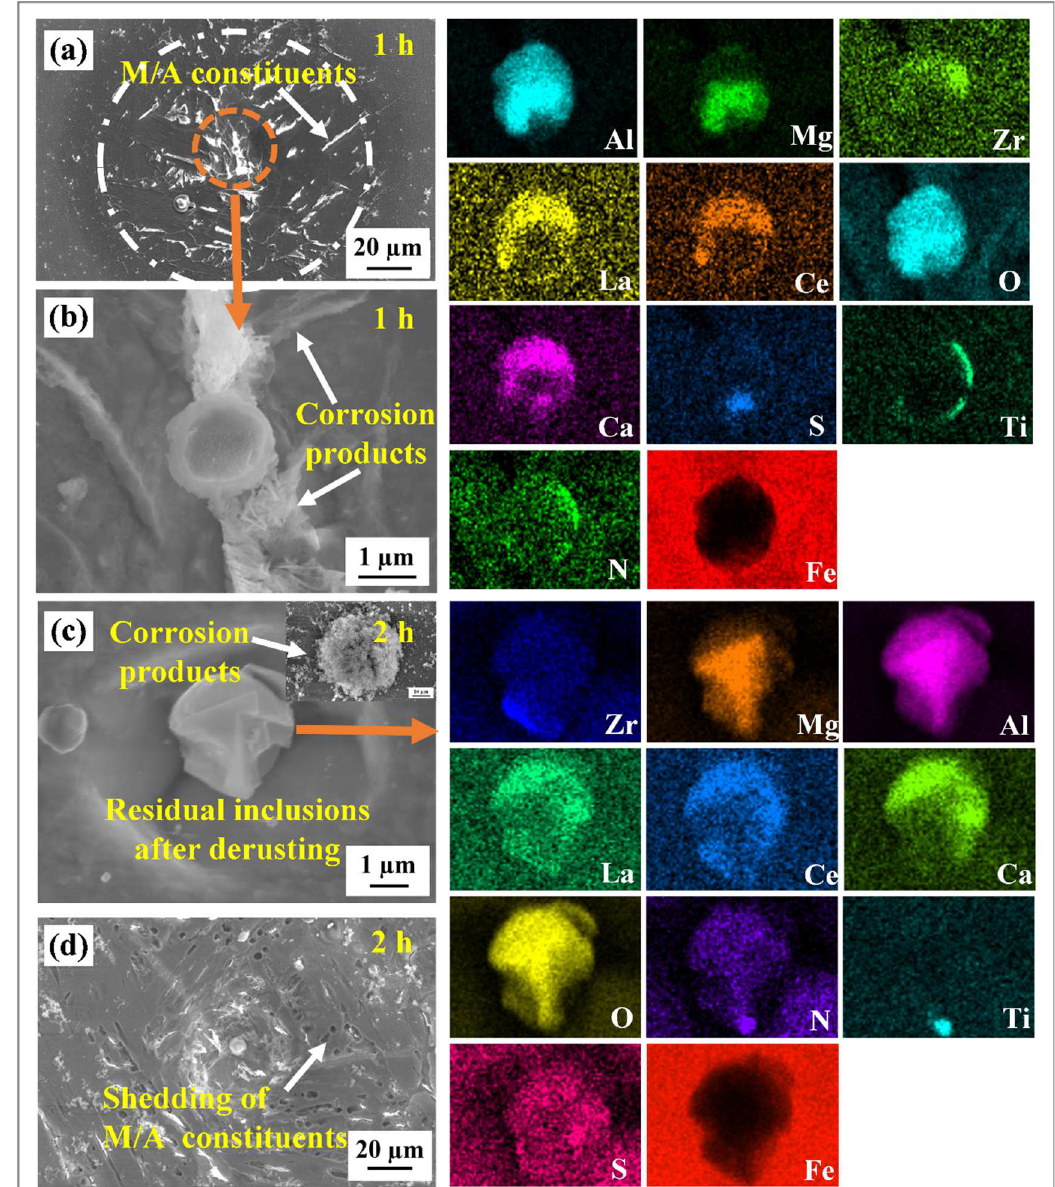
Figure 9. SEM images and EDS results of the immersion test; ( a , b ) immersion for 1h and ( c , d ) im- mersion for 2 h.